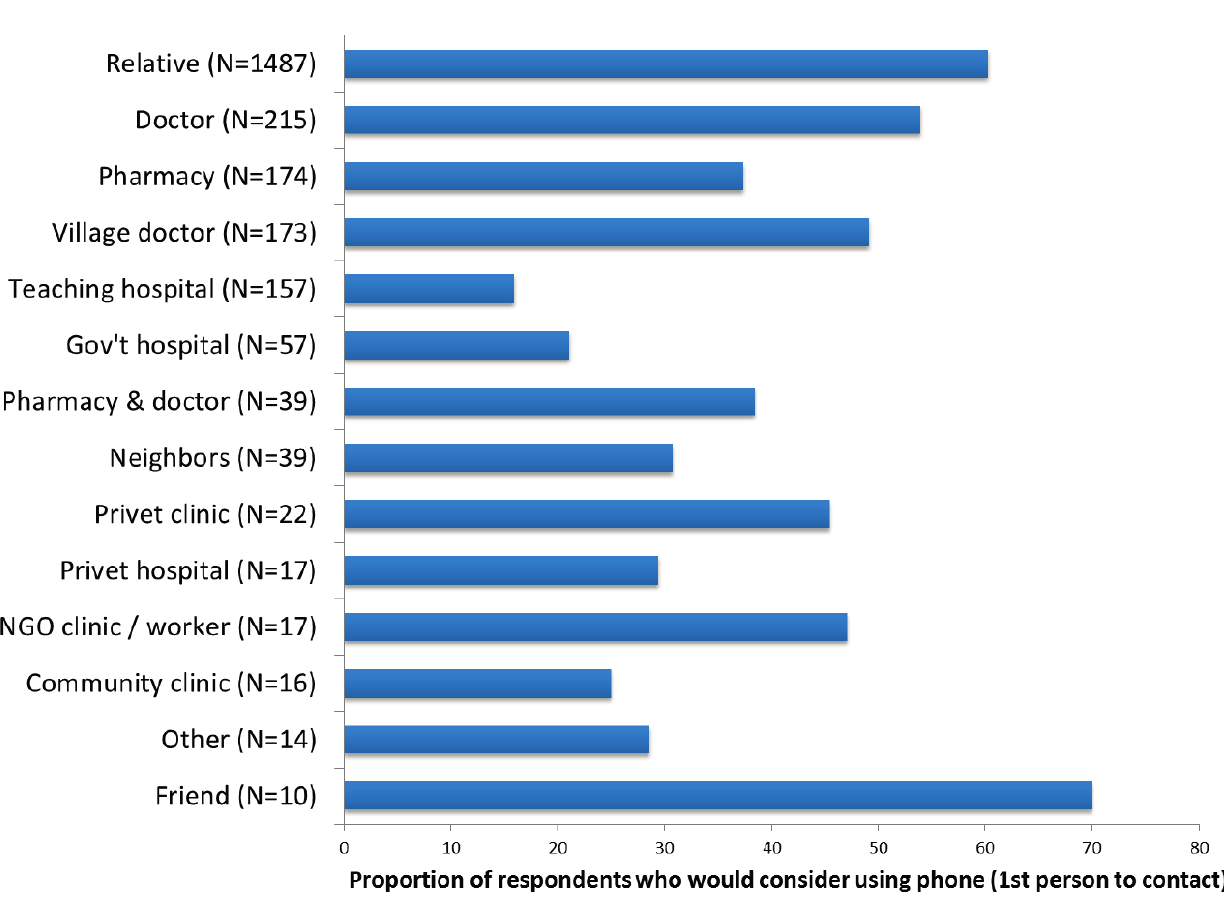
Figure 2. Proportion of respondents who would consider using their phone to make first contact when seeking health information. Authors survey